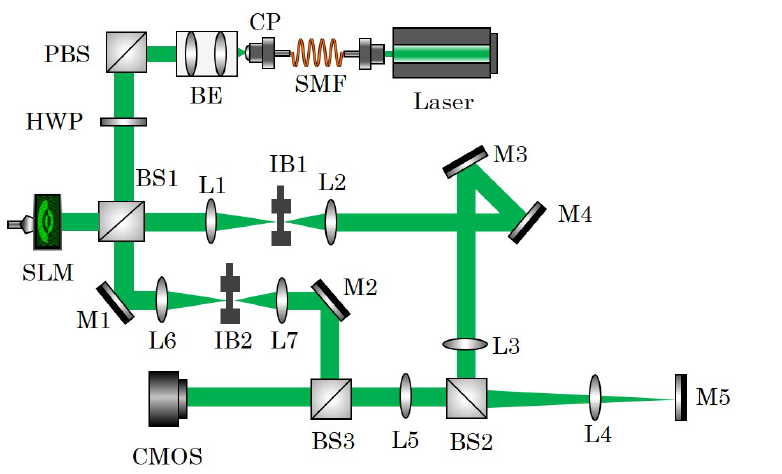
Figure 4. Optical setup, which is used to generate random mode field distributions using an SLM. The generated light fields can be measured either purely intensity-based or holographically. Table 2. Mean relative errors of the mode weight determination using Digital Holography (DH) or a DNN.